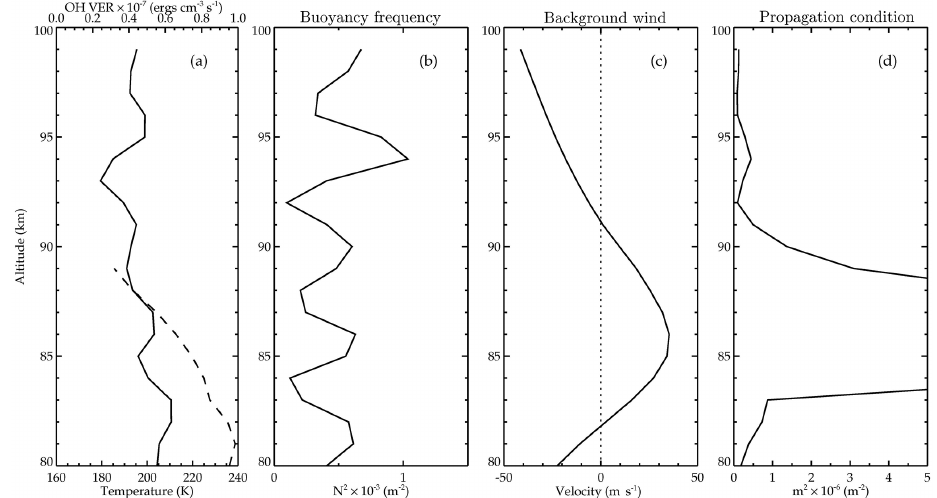
Figure 7. Same as Fig. 5 but for the mesospheric front observed on 27 August 2011.